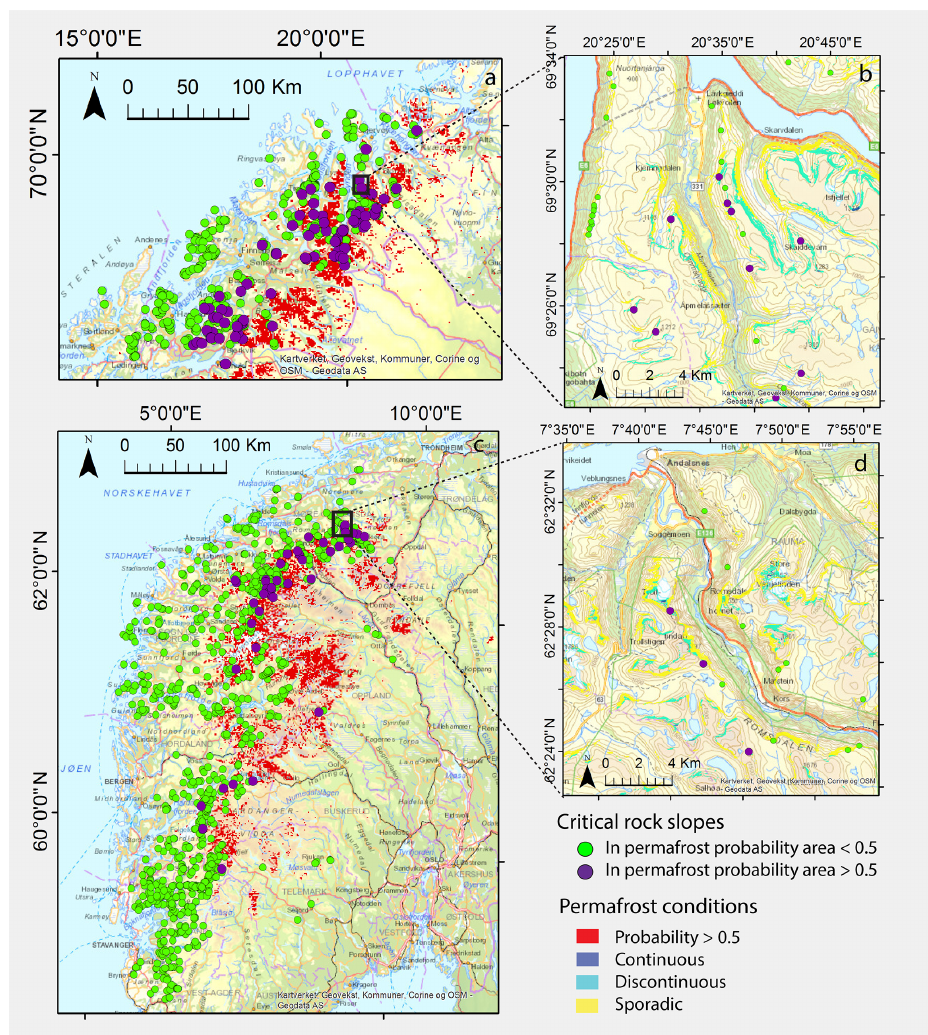
Figure 14. Distribution of inventoried ice-cored moraines and active rock glaciers compared to the CryoWall map and the Nordic permafrost map from Gisnås et al. (2017) at 1km